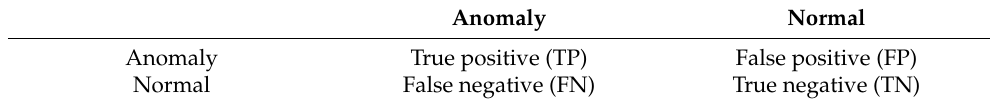
Table 1. Confusion matrix used in this study.